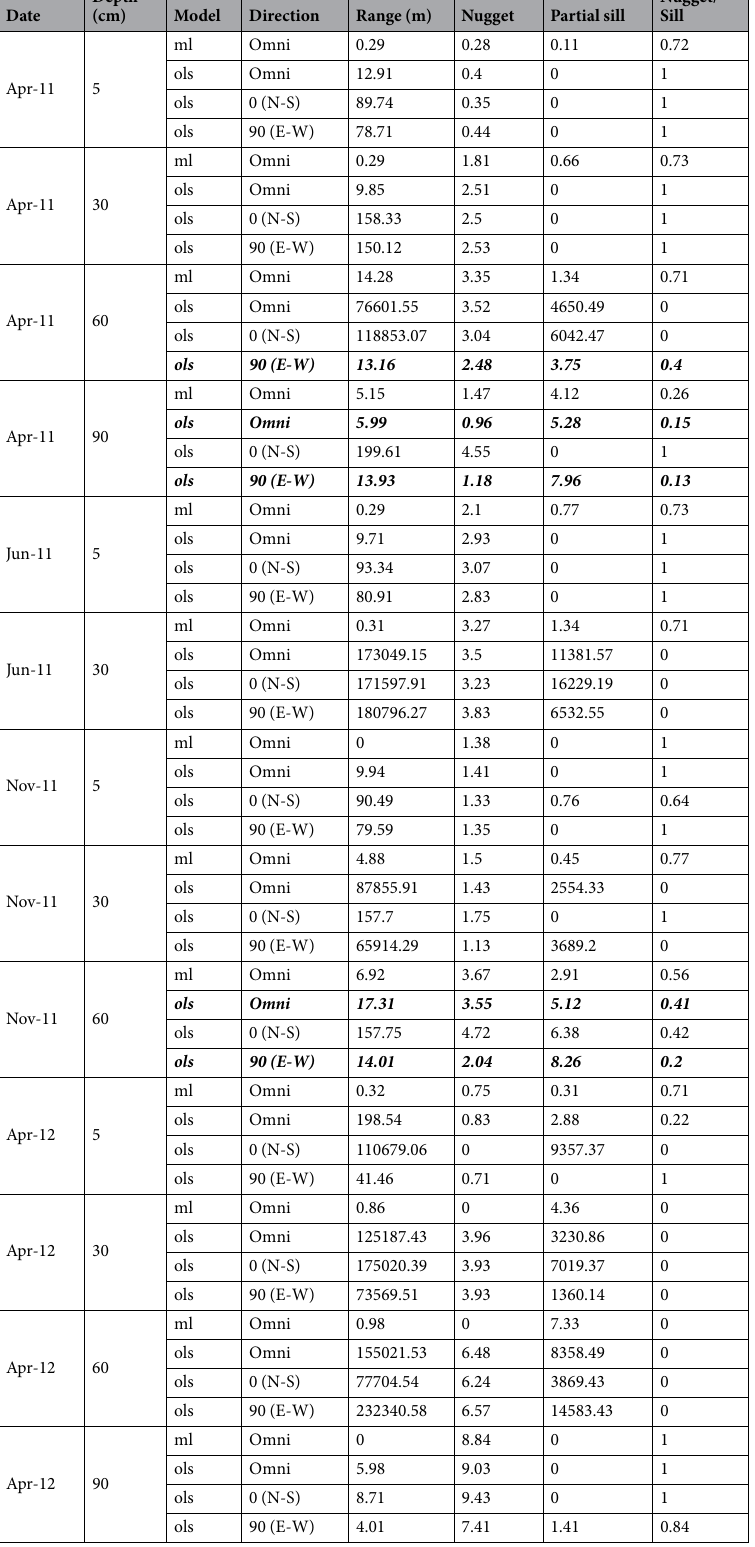
Table 2. Summary of parameters obtained from fitting maximum likelihood (ml) and ordinary least squares (ols) models to omnidirectional (Omni) and directional (0 (N-S); 90 (E-W)) empirical semivariograms corresponding to the spatial distribution of log-transformed B. pseudomallei counts. Italicized bold lines correspond to models from which spatial auto-correlation could be